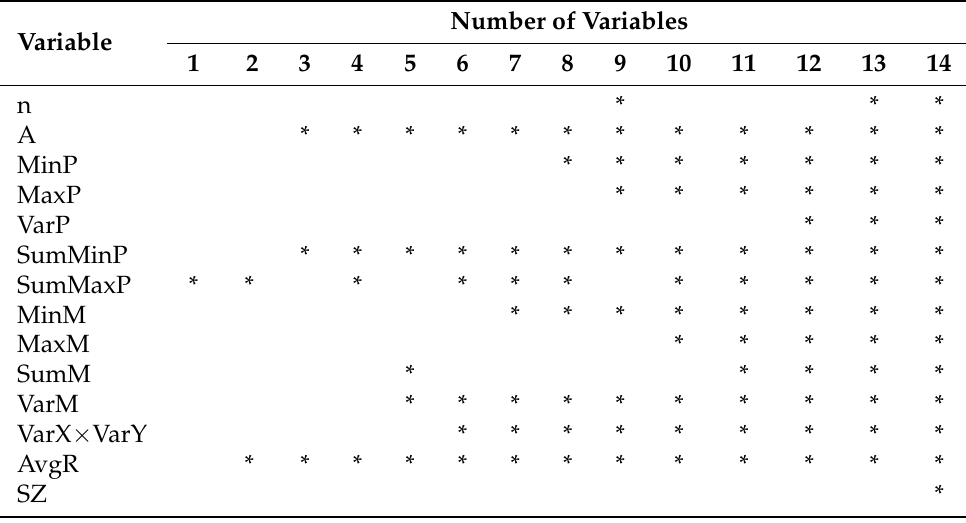
Table 3. Best subset models based on adjusted R 2 .